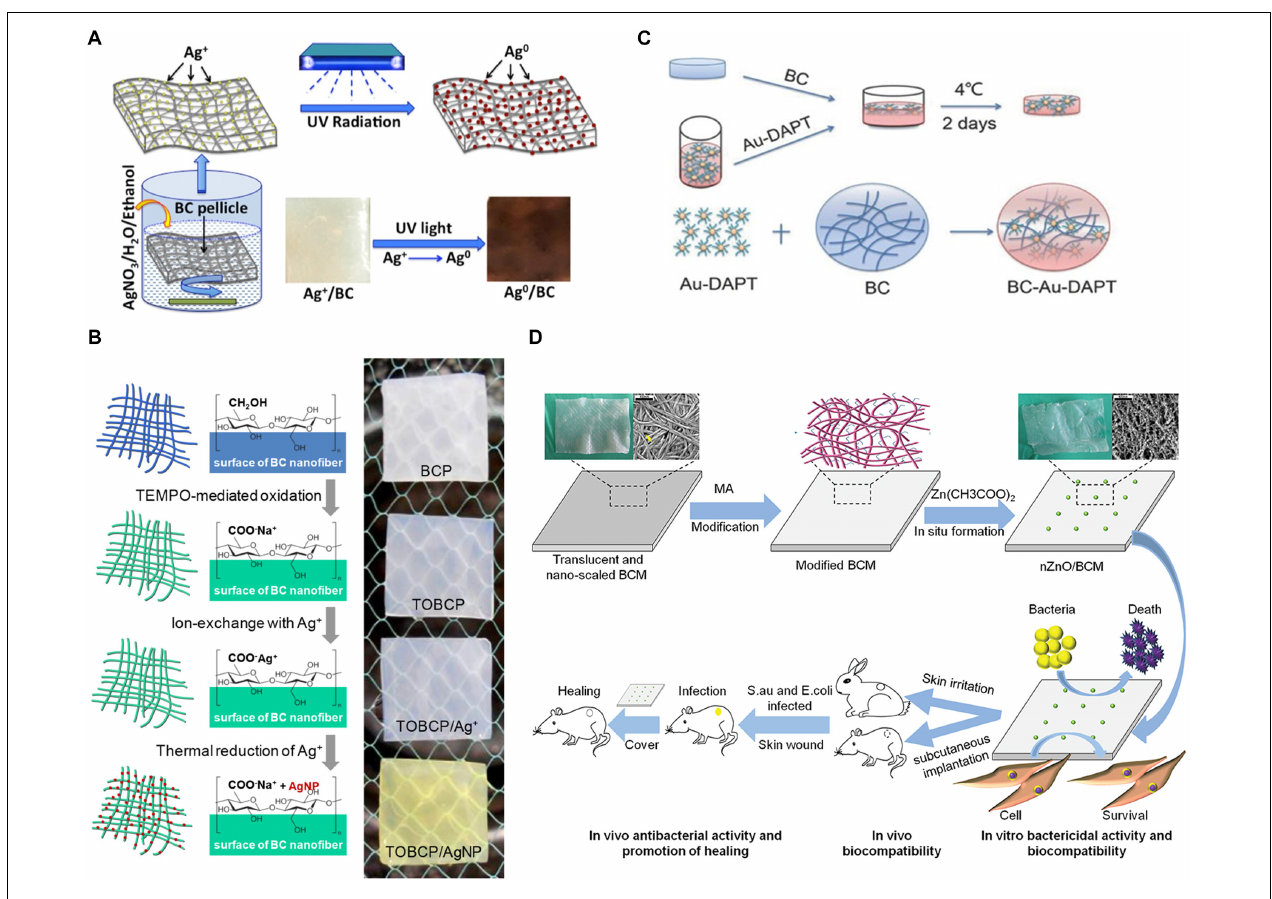
FIGURE 5 | (A) Ag/BC films prepared by photochemical deposition (Pal et al., 2017). (B) TOBCP/Ag NPs films prepared by thermal reduction method (Wu C. -N. et al., 2018). (C) BC-Au- DAPT nanocomposites prepared by solution dipping method (Li et al., 2017). (D) nZnO/BCM composites prepared by in situ deposition method (Luo et al.,